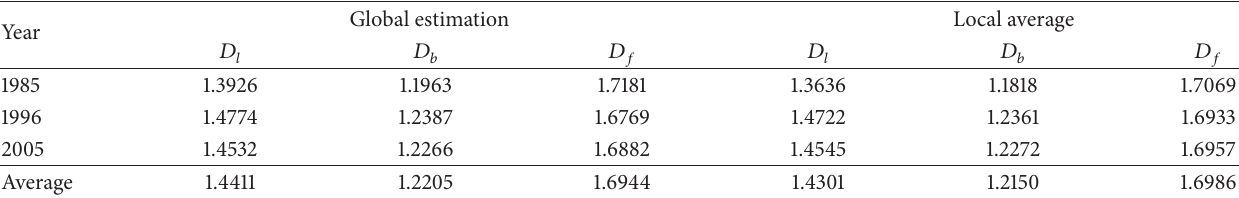
Table 4: A comparison between the global fractal parameters and the average local fractal parameters of the cities and towns in Yangtze River Delta, China (1985–2005).